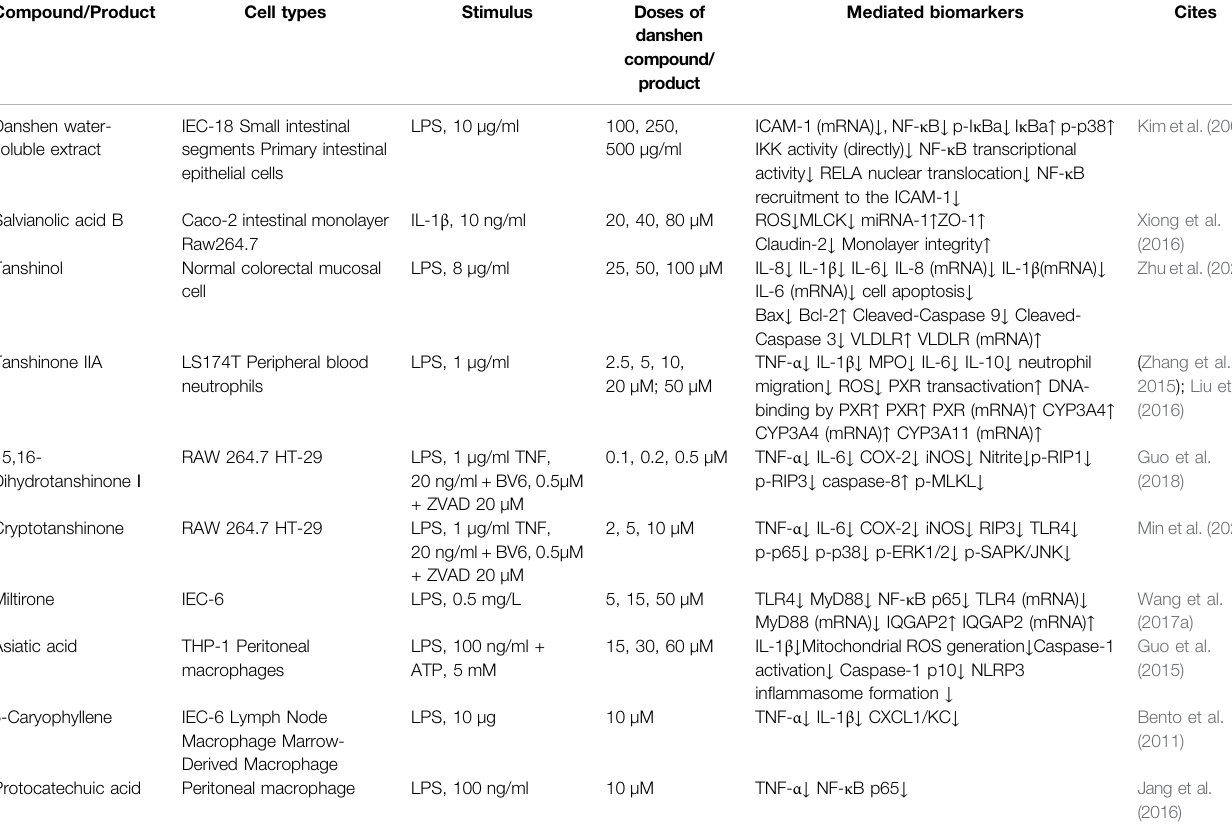
TABLE 2 | Pharmacological details of action of Danshen compounds in vitro or ex vivo